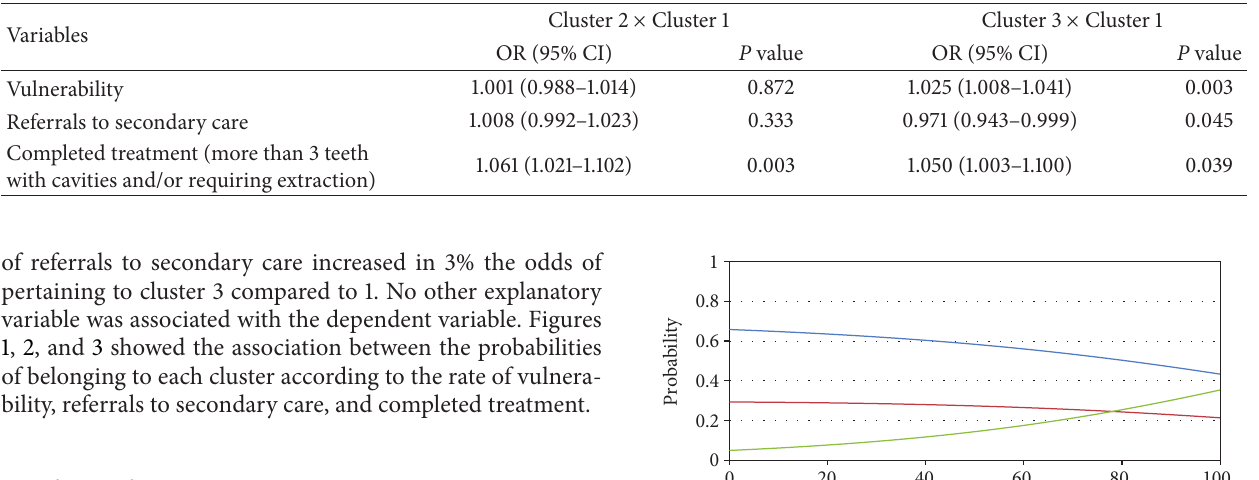
Table 4: Multivariate multinomial logistic regression, Belo Horizonte, 2010.